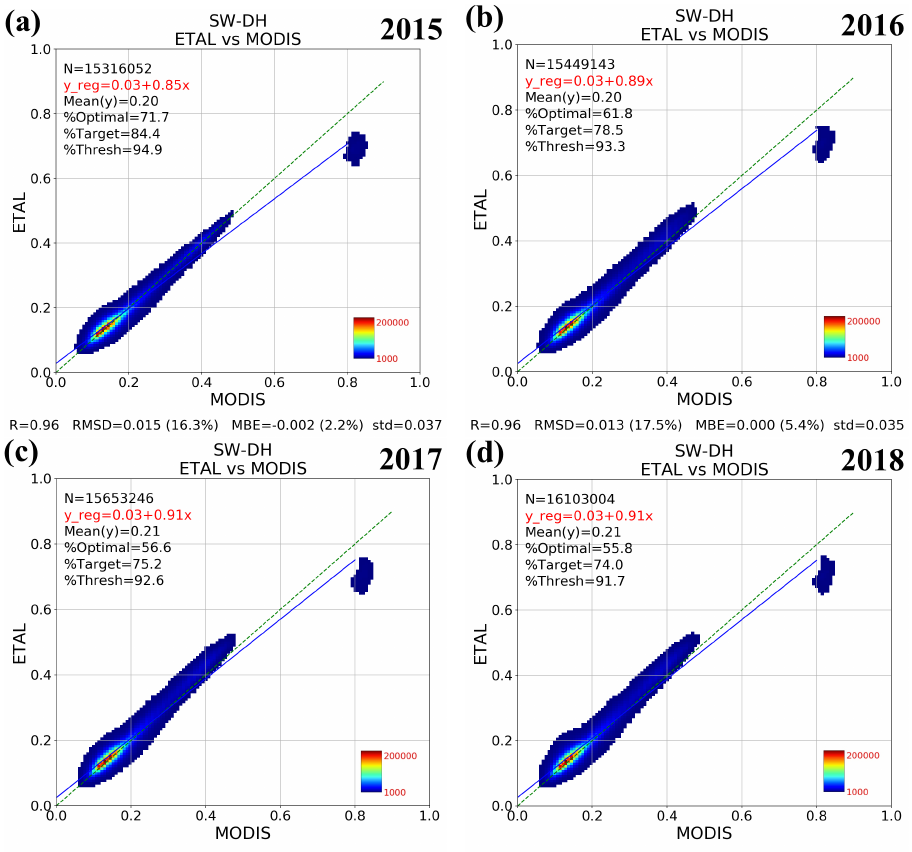
Figure 13. Density scatter plots for the inter-comparison of ETAL versus MODIS for: ( a ) 2015; ( b ) 2016; ( c ) 2017; and ( d ) 2018. To maintain a reasonable number of samples, a spatial subsampling of 1:10 is considered. The green dashed line is the 1:1 line, and the blue line is the regression line. Absolute MBE and RMSD are calculated over albedo values less 0.15 while relative MBE and RMSD (in %) are calculated over albedo values greater than